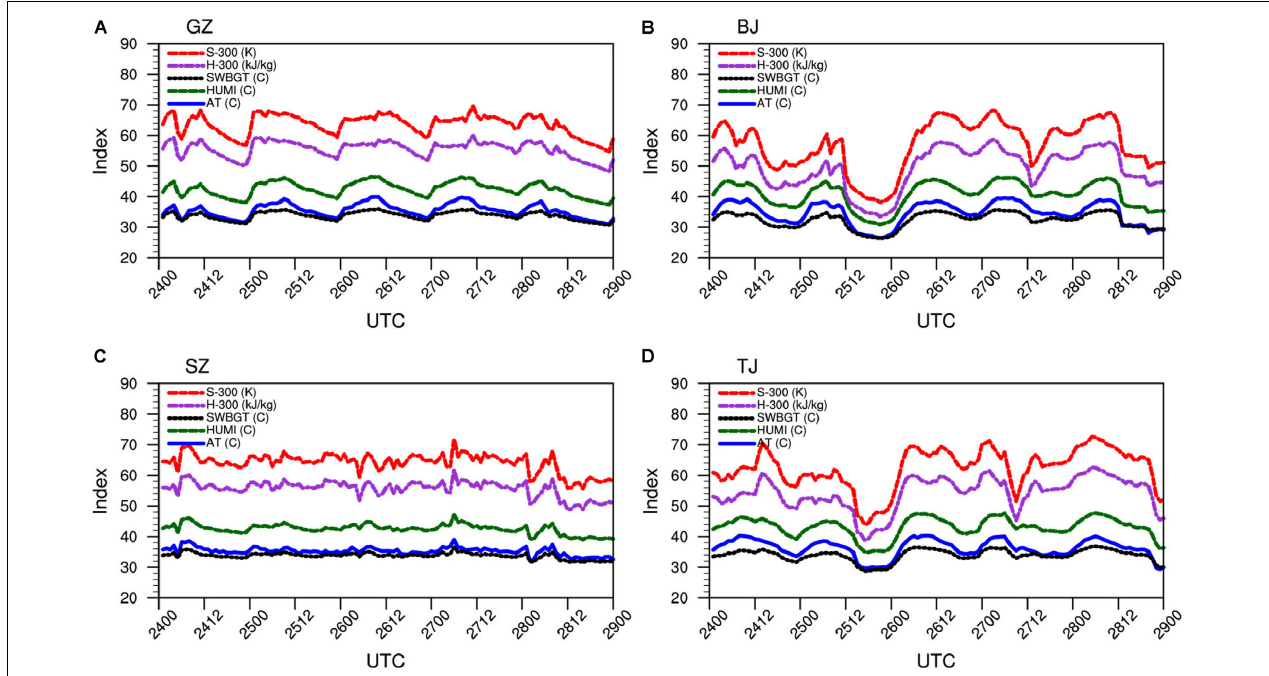
FIGURE 4 | (A–D) Curves of five metrics to evaluate heat stress intensity evolution over GZ, SZ, BJ, and TJ city regions based on multi-station observations. Five metrics are apparent temperature (blue), Humidex (green), and simplified wet bulb globe temperature (black) ( ◦ C), moist enthalpy ( H , purple) (K J/kg), and moist entropy ( S , red) (K), respectively, where H and S minus 300 K in magnitude, to be comparable with other metrics.